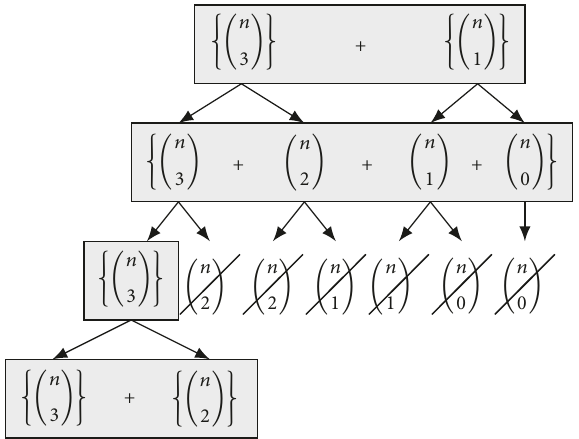
Figure 5: Binomial representations of the 4 shifted versions of the sequence {( 𝑛 3 ) + ( 𝑛 1 )} . Table 2: Rules 102 and 60.